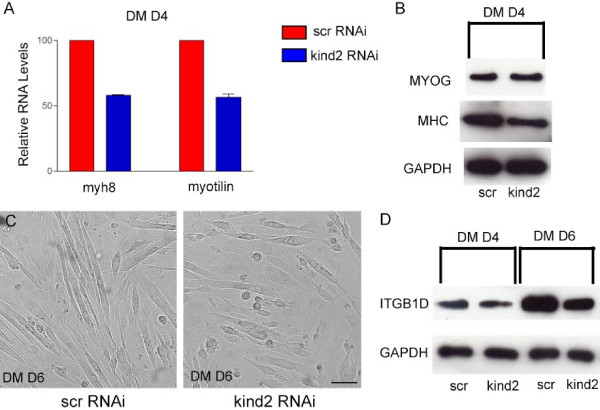
Altered expression of differentiation markers and kindlin-2 knockdown. A. Relative RNA levels of myh8 and myotilin in RNAi transfected, 4 day differentiated C2C12 cells as determined by qPCR. Each value was calculated from 3 independent transfections with qPCR performed in triplicate. In kindlin-2 RNAi transfected cells, myh8 and myotilin levels were 58 +/-1% and 56+/-3%, respectively, of the values obtained for control cells. B. Immunoblot on protein extracted from day 4 differentiated samples transfected with scrambled or kindlin-2 RNAi. Blots were probed with the following antibodies: myogenin (myog), myosin heavy chain (MHC), and GAPDH (loading control). Densitometric analysis revealed no difference in myogenin levels between samples, and a reduction to 75% of normal for MHC. C. Brightfield images of scrambled (scr) or kindlin-2 (kind2) RNAi transfected C2C12 cells incubated in differentiation media for 6 days (DM D6). Note extensive myotube formation in the scrambled sample as compared to the kindlin-2 RNAi sample. D. Immunoblot of day 4 (DM D4) and day 6 (DM D6) differentiated myocytes transfected with scrambled (scr) or kindlin-2 (kind2) RNAi. Blots were probed with antibodies to β1D integrin and GAPDH. Densitometric analysis revealed 75% and 77% reductions respectively in β1D integrin levels in kindlin-2 RNAi samples.